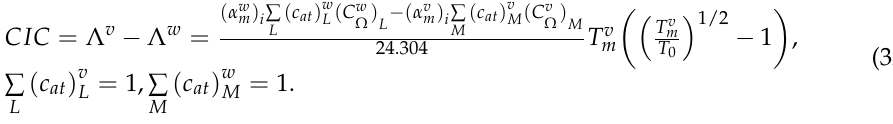
Figure 3. Fragment of the EP648 structure with a crack (indicated by an arrow): ( v ) is the point with concentrations of chemical elements L = Ni , Cr , W , Mo , C ( c v L the distance between points ( v ) and ( w ).